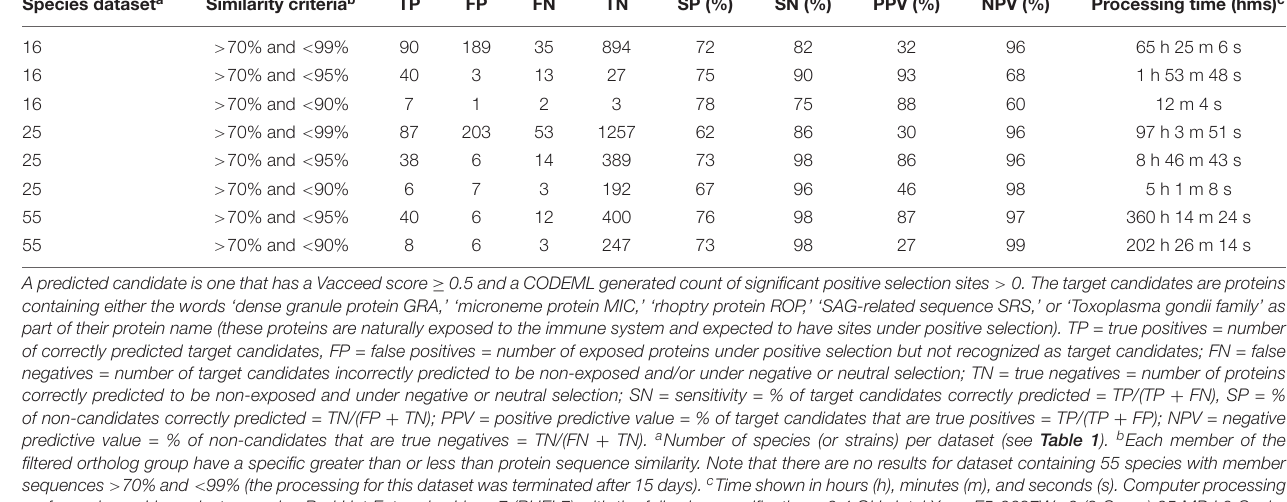
TABLE 4 | Comparisons between predicted outcomes from different species datasets when predicting target candidates for Toxoplasma gondii ME49. Species dataset a Similarity criteria